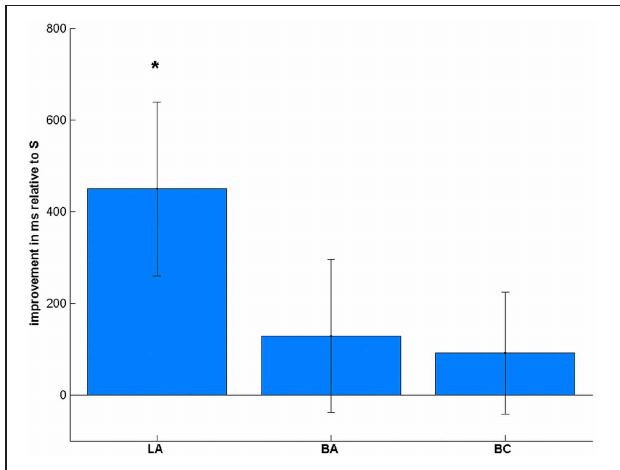
FIGURE 5 | Stimulation-induced improvements in reaction times in complex subtractions. LA stimulation led to significant performance increases, whereas the other conditions did not change significantly. ∗ p < 0 . 05, multiple comparison corrected.